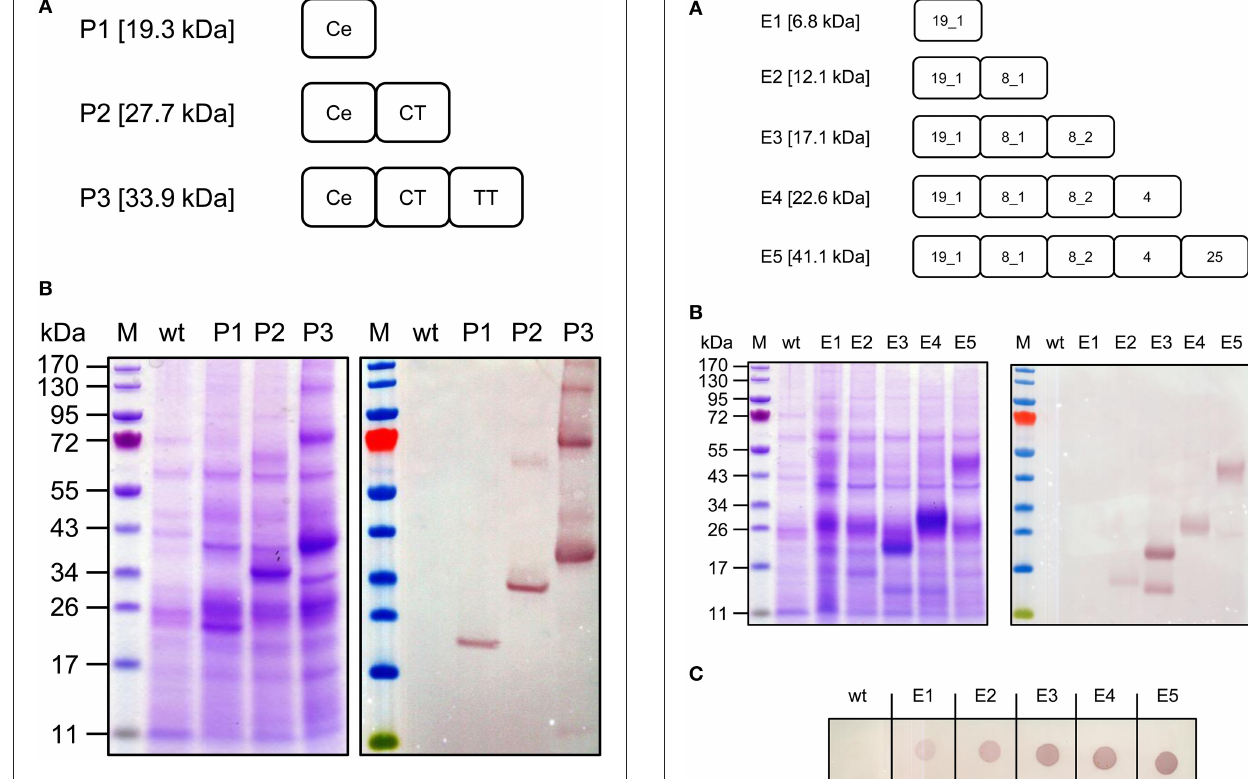
FIGURE 6 | Construction and expression of the pre-erythrocytic stage candidate (variants P1–P3). (A) Construct architecture. For antigen abbreviations refer to Table 1 . (B) SDS-PAGE and western blot analysis of pre-erythrocytic stage candidate variants. Heat-treated crude extracts were separated under reducing conditions and analyzed by staining with Coomassie (left panel) or by western blot using rabbit anti-His 6 and alkaline phosphatase-labeled goat anti-rabbit antiserum. M, PageRuler TM pre-stained protein ladder (Fermentas); wt, non-infiltrated leaf extract.